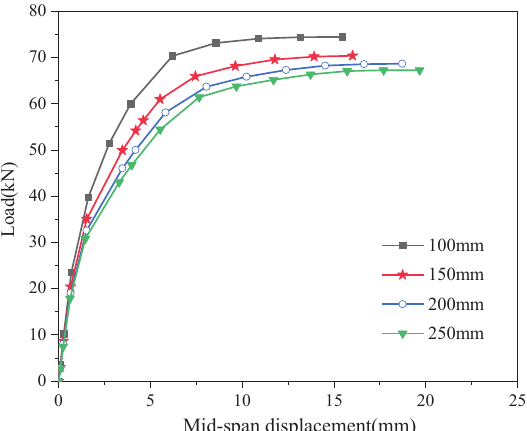
Figure 16. Load-mid-span displacement curves of composite slabs with different stud spacings.